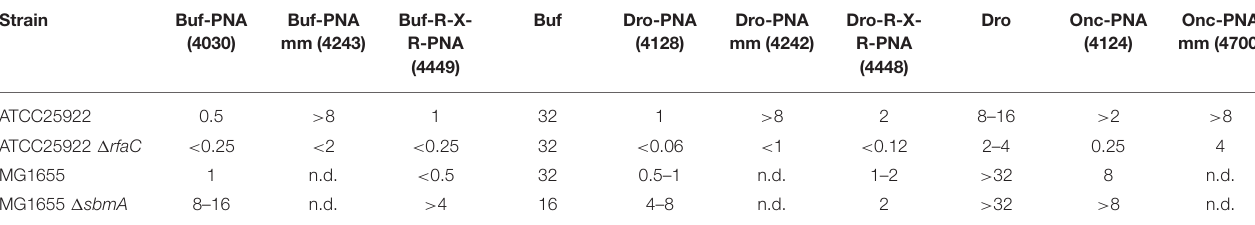
TABLE 3 | MIC values ( µ M) of BPP-PNA constructs composed of naturally occurring BPPs; buforin 2a (Buf), drosocin (Dro), and oncosin (Onc) conjugated to the anti- acpP -PNA. Strain